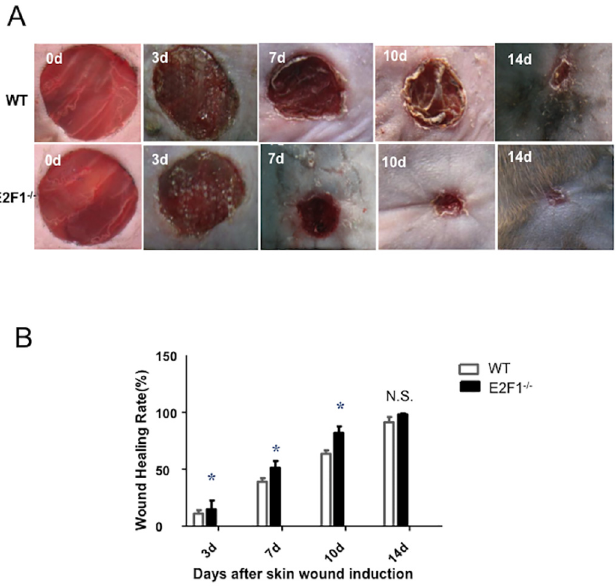
Fig 1. E2F1-deficiency accelerates wound healing. (A) Representative skin wounds in WT and E2F1 – / –